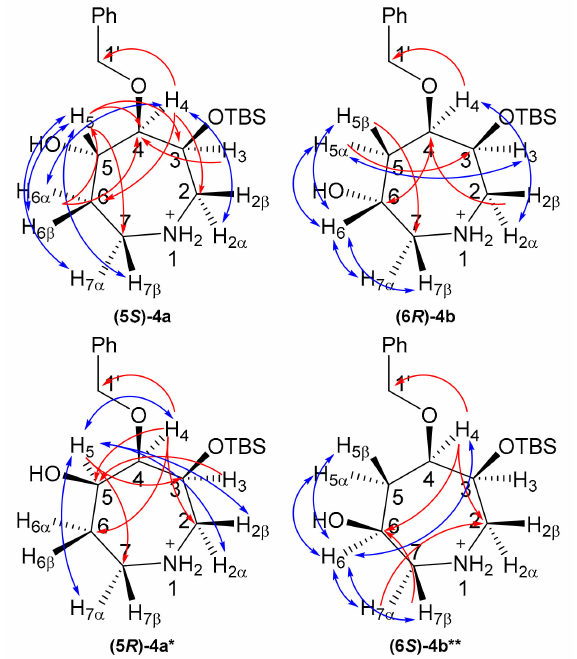
Figure 1. 2D-NMR correlations for azepanols (5 S )-4a and (6 R )-4b . Red, HMBC; blue,